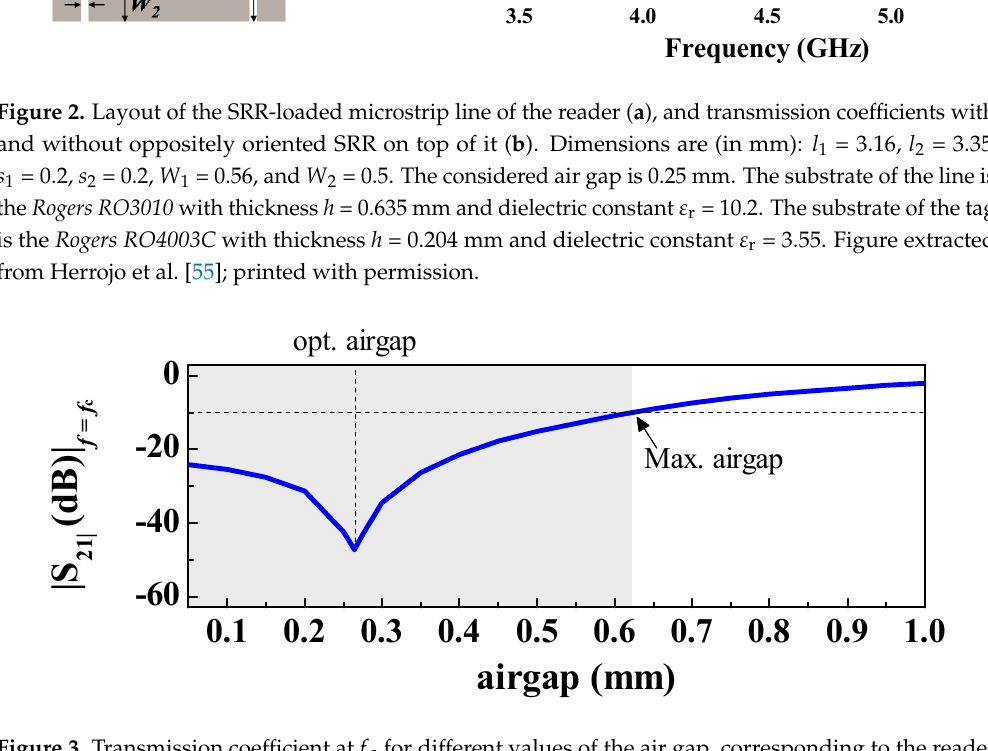
Figure 3. Transmission coefficient at f c for different values of the air gap, corresponding to the reader loaded with perfectly aligned SRR. Figure extracted from Herrojo et al. [54]; printed with permission.